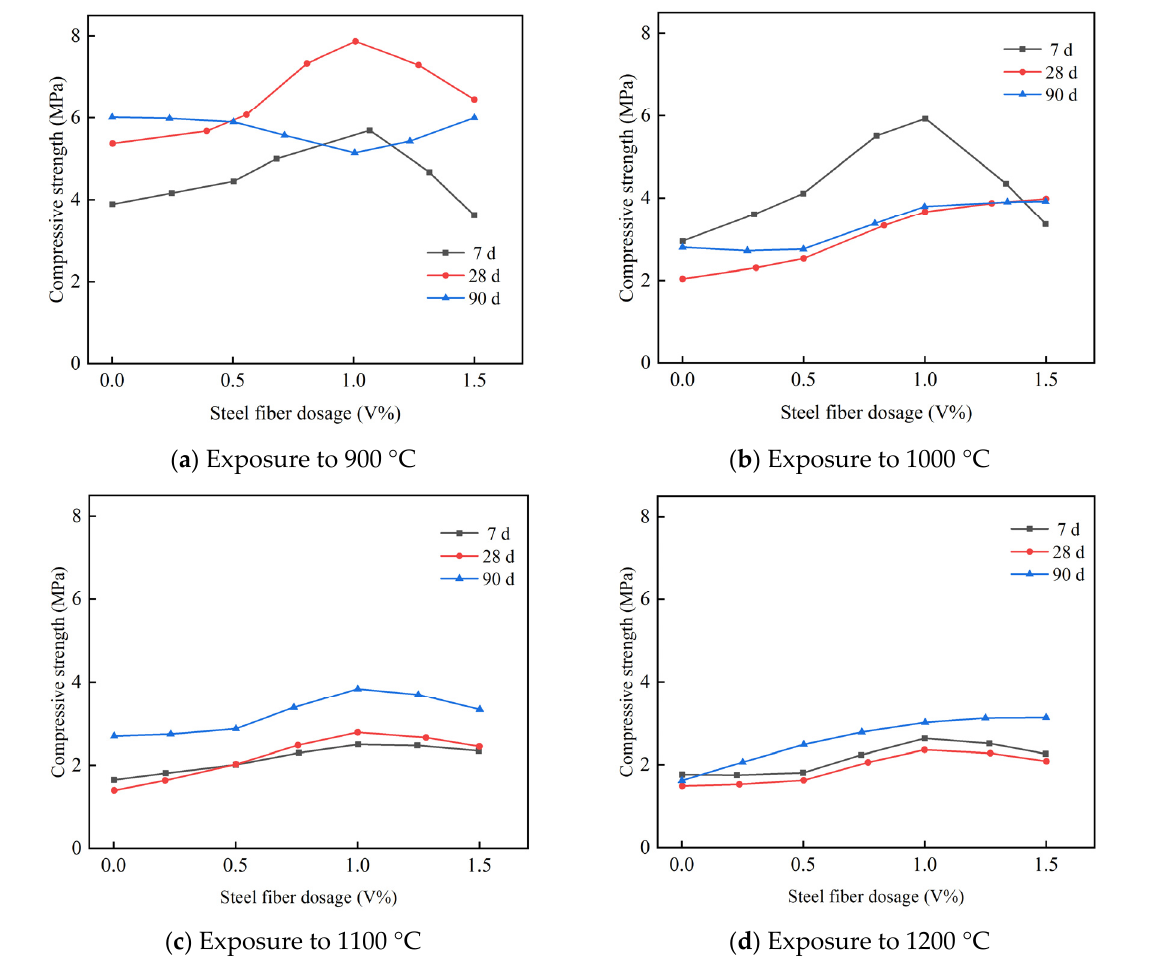
Figure 3. Relationship between compressive strength of SFRC and steel fiber dosage [40].